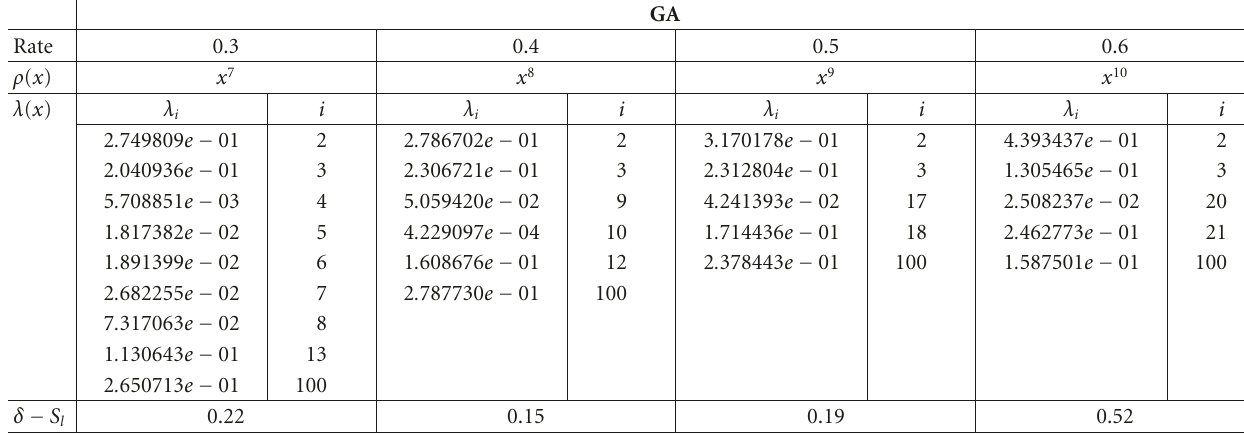
Table 1: Optimized LDPC codes for the 2-user Gaussian channel obtained with the Gaussian Approximation of the state-check node. The distance between the ( E b /N 0 ) threshold δ (evaluated with true DE) and the Shannon limit S l is given in dBs.